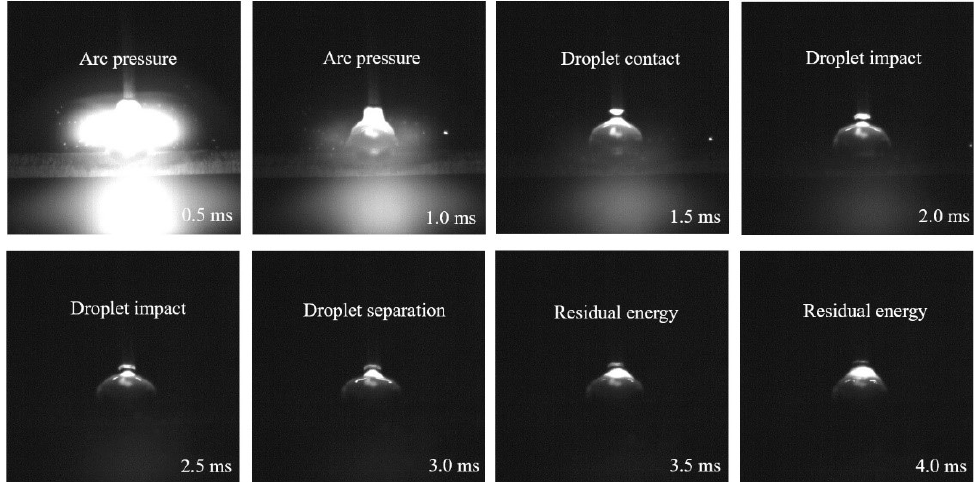
Figure 11. Controlled driving cycle of the molten pool with a welding current of 80 A.